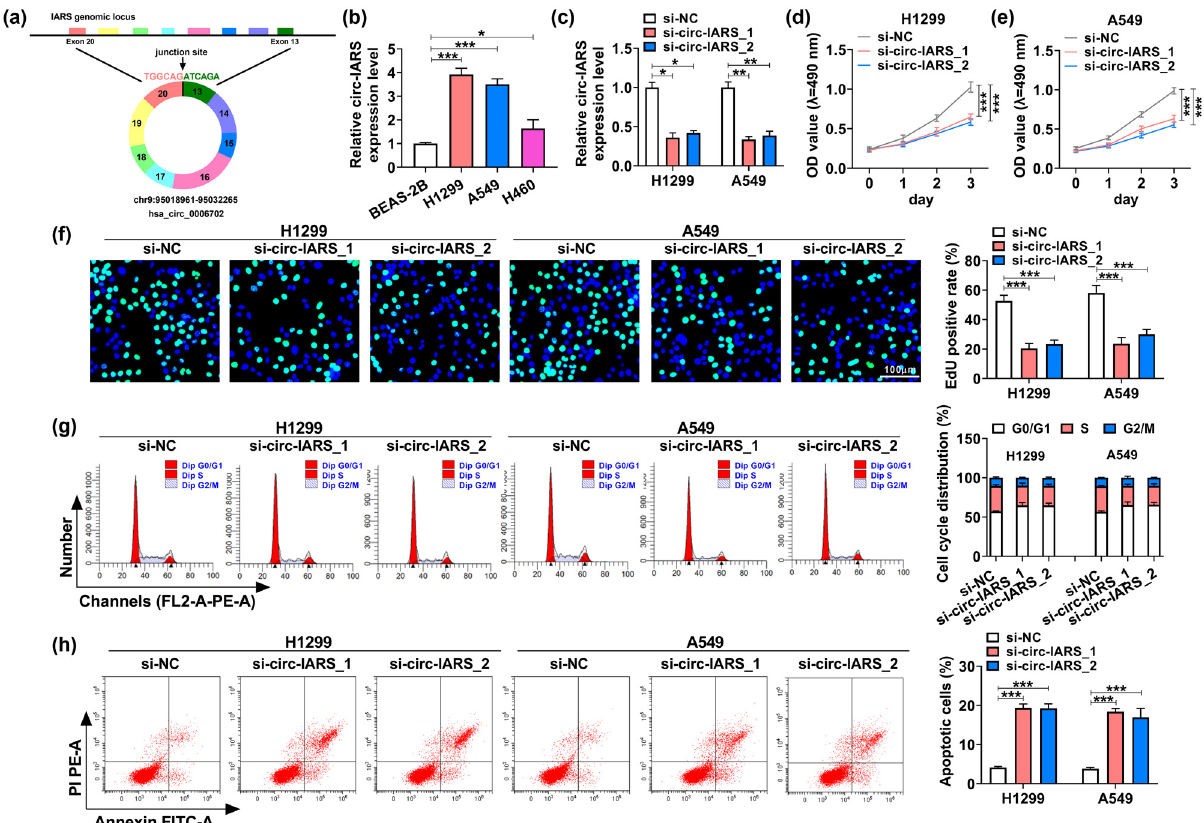
Figure 1: Exhausting circ - IARS could antagonize NSCLC cell growth. ( a ) Schematic diagram showing the back - splicing of exons 13 – 20 of the IARS gene generating the circRNA hsa_circ_0006702. ( b and c ) RT - qPCR is used to measure the relative circ - IARS expression level in ( b ) H1299, A549, H460, and BEAS - 2B cells, and in ( c ) H1299 and A549 cells transfected with si - circ - IARS_1, si - circ - IARS_2, or si - NC. In transfected H1299 ( d ) and A549 cells ( e ) , MTT assay monitored the OD value at 490 nm, ( f ) EdU assay determined the EdU - positive rate, ( g and h ) FCM method analyzed the cell cycle distribution ( % ) in G0/G1, S, and G2/M phases, and apoptotic cells ( % ) . * P < 0.05, ** P < 0.01, and *** P <